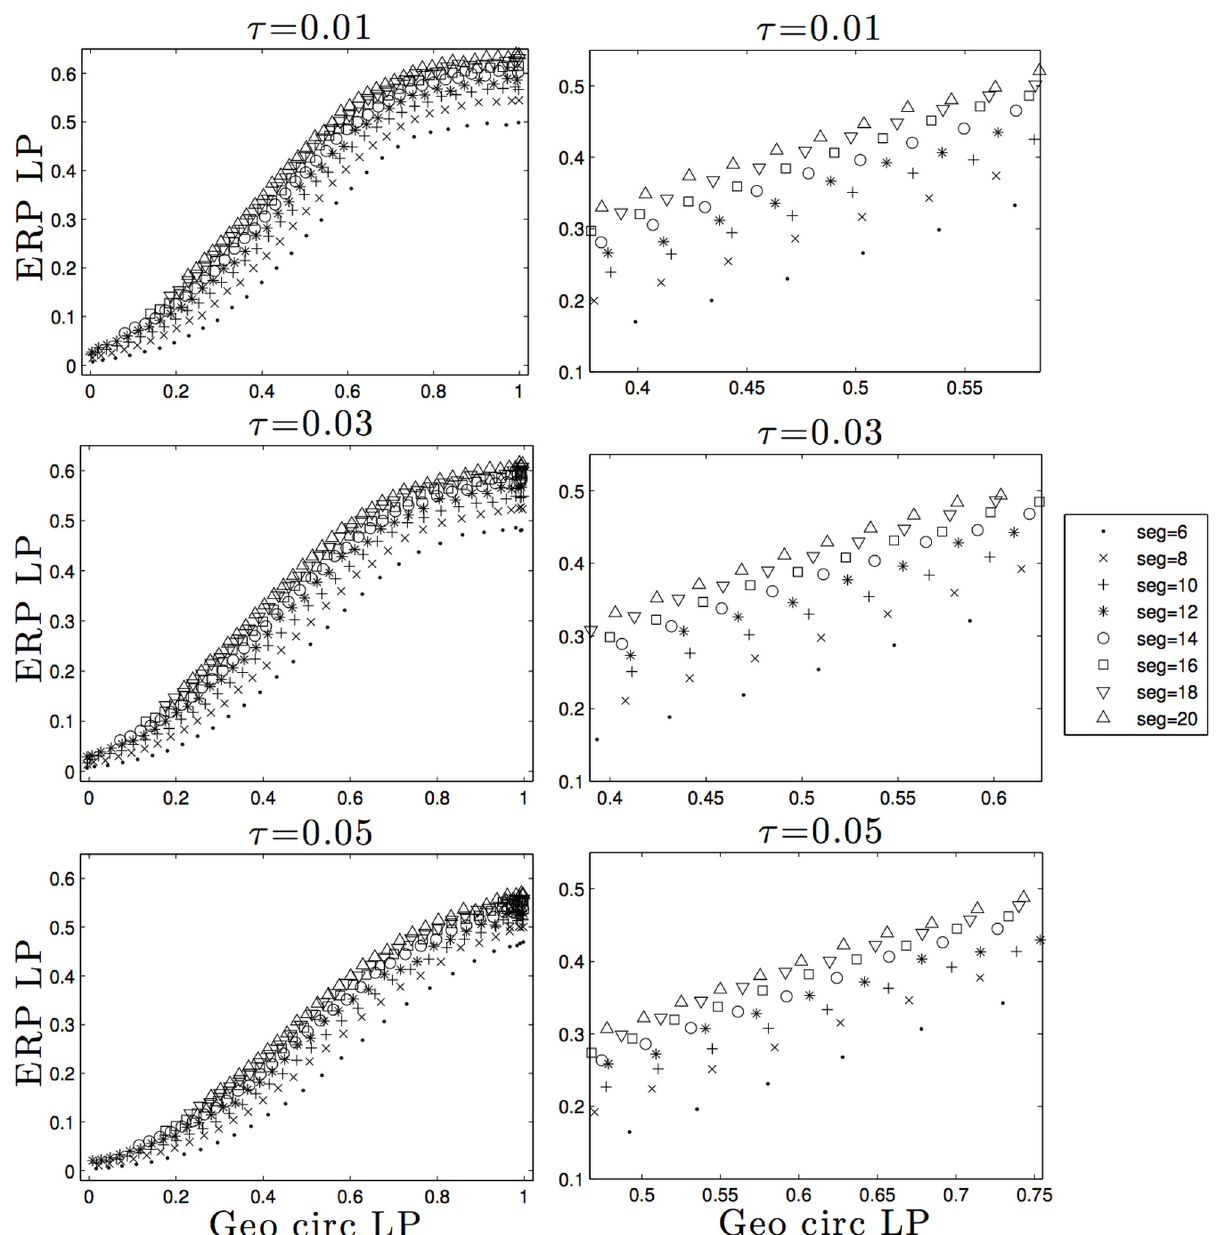
Fig 3. Relationship between the linking probability (LP) of rigid (Geo Circ) and freely jointed minicircles (ERP) with volume exclusion.